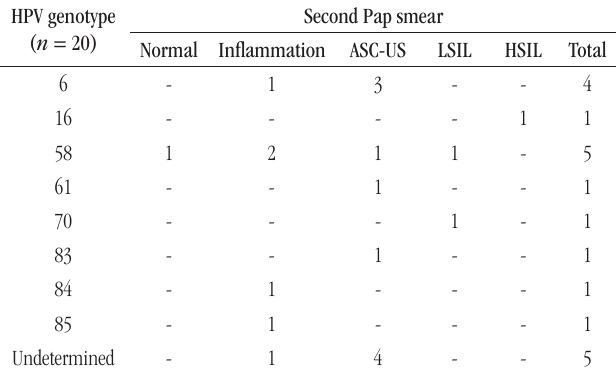
taBLE 3 – Distribution of HPV genotypes according to